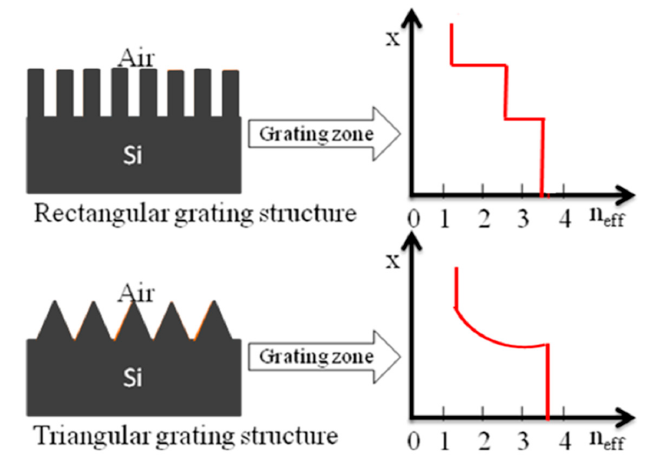
Figure 3. Nano ‐ structured grating of rectangular (or flat type) ‐ and triangular (or conical) ‐ shaped profile, and the plot of SWG height versus the effective refractive index ( n ) for a silicon (Si) substrate [16,17].